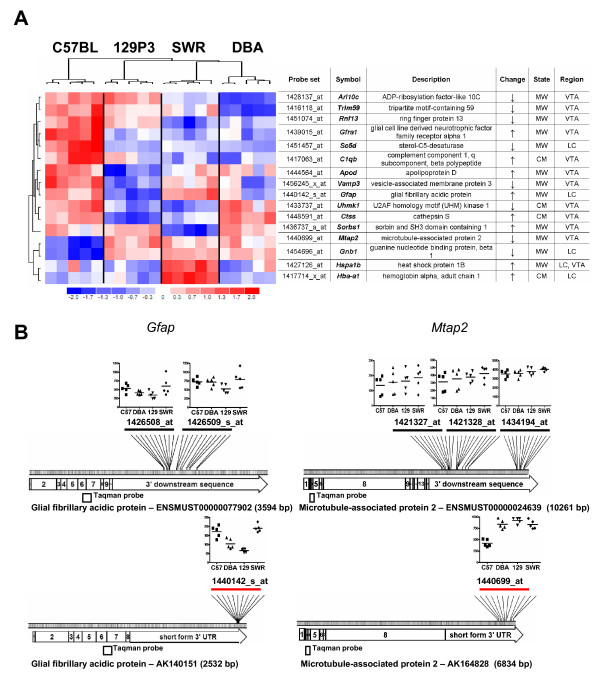
Comparison of basal gene expression between the selected inbred mouse strains, regulated by administration in the locus ceruleus (LC) or ventral tegmental area (VTA) of the C57BL/6J mice [34]. A. Cluster of genes whose expression was different according to array analysis. Coloured rectangles represent expression levels of the gene indicated on the right. Intensity of the colour is proportional to the fold change as indicated on the bar below the cluster image. The selected genes were previously found to be regulated by opioid administration as described on the right, after chronic morphine administration (CM) and morphine withdrawal (MW), respectively. Directions of the changes are indicated by arrows: (↑) – up-regulation and (↓) – down-regulation. Relative expression levels were measured by MBEI method. B. Expression level of Gfap and Mtap2 in the striatum, obtained by microarray experiment. Putative short mRNA forms detected by microarray probe-sets (Gfap – 1440142_s_at, Mtap2 – 1440699_at) are presented below. The image displays signal intensity from individual array with emphasized mean value.